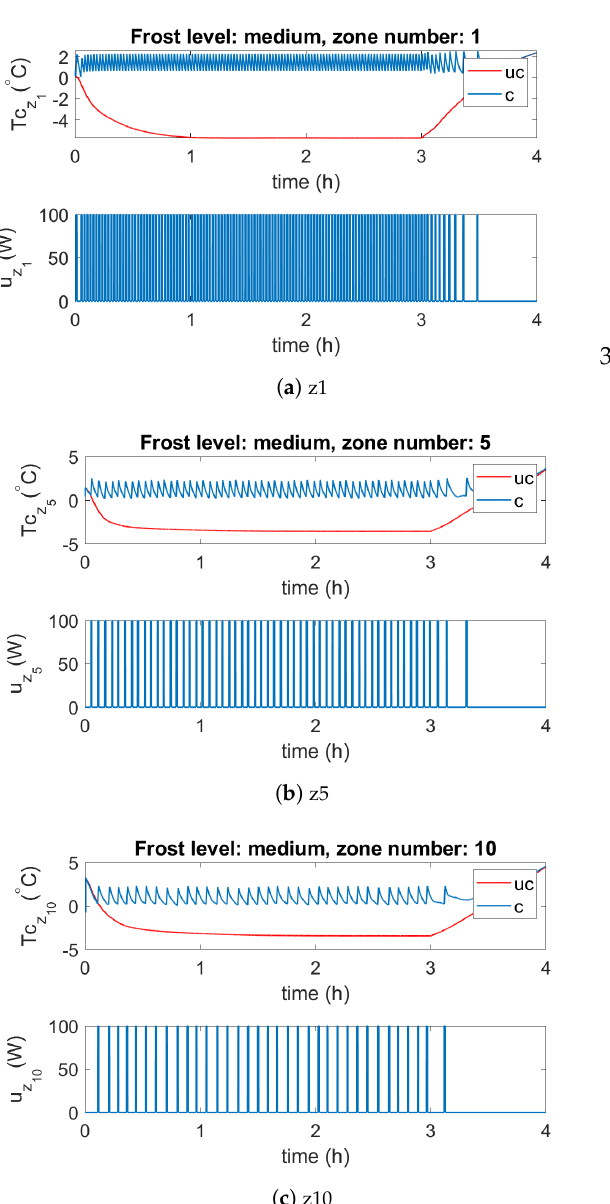
Figure 7. Medium frost canopy temperature simulation results for selected zones z 1 , z 5 , and z 10 . Here, “uc” and “c” denote uncontrolled and controlled cases,